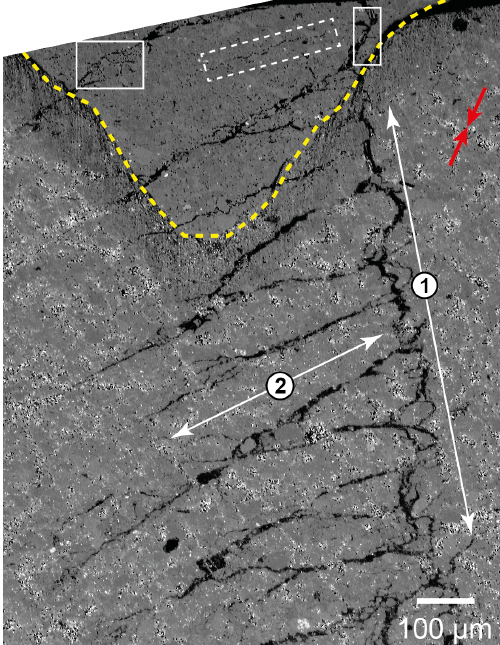
Figure 6. Larger field of BSE–SEM micrograph of the BIB cross section overview at ROI-1 in COX-2MPa sample. It shows the net- work of antithetic fractures (indicated by number 1) oblique to the principle main synthetic fracture (indicated by number 2). The left white box in solid lines refers to Fig. 7f; the white box in dashed lines refers to Fig. 7a and the right white box in solid lines refers to Fig. 8. Orientation of the principal stress ( σ 1 ) is indicated by red arrows. The bedding is perpendicular to σ 1 . Dashed yellow lines indicate the boundaries of the BIB-polished areas.